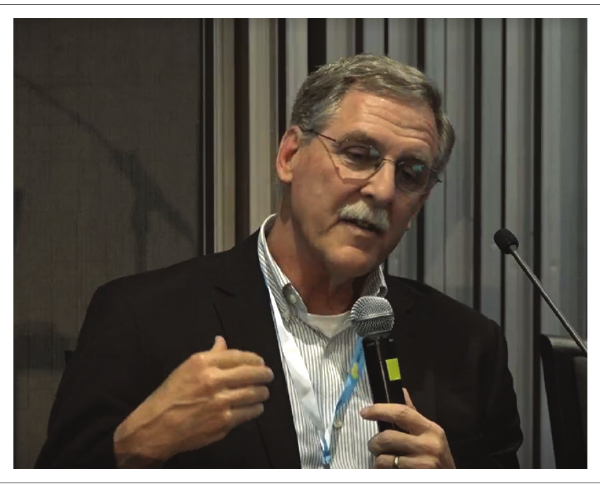
FIGURE 1: Photograph taken by Antfarm, 06 February 2020, Johannesburg, published with permission from